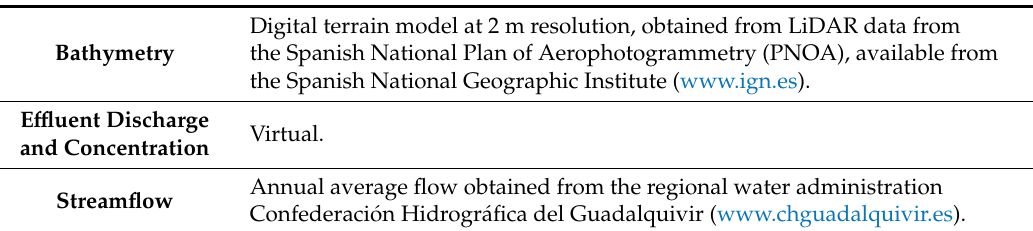
Table A4. Data sources for the Test Case